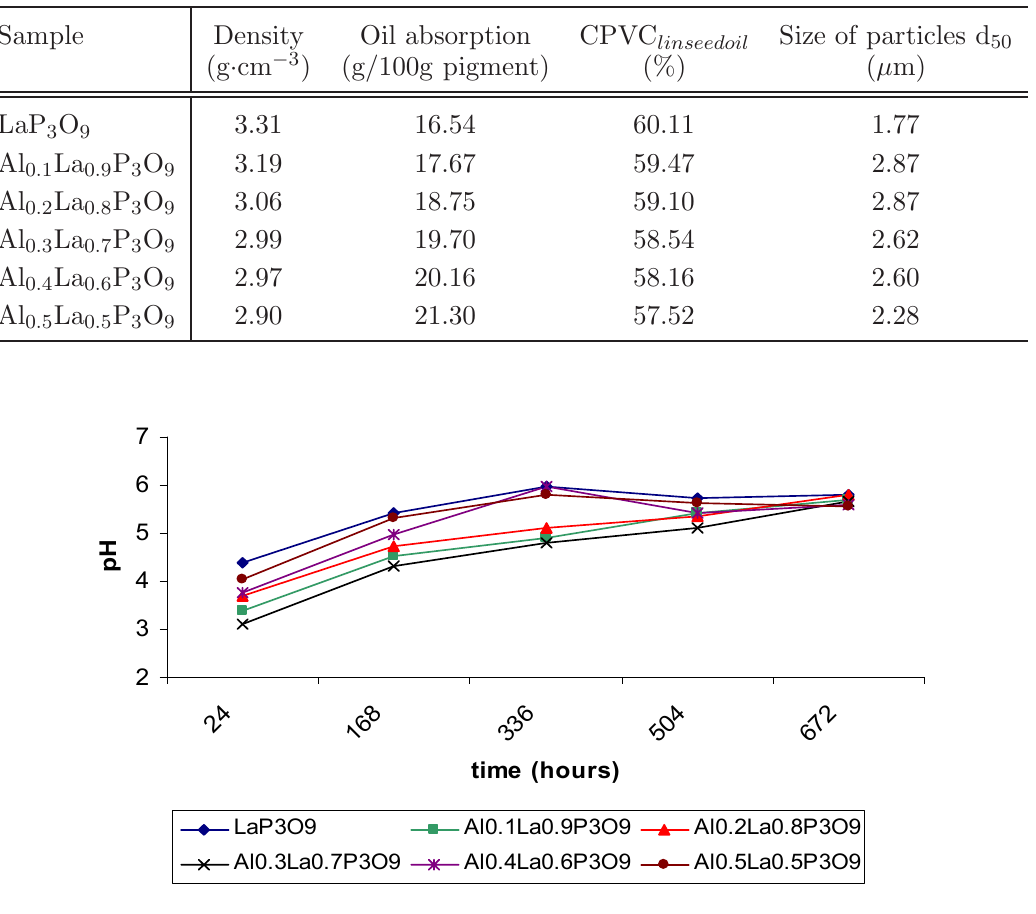
Fig. 7 pH of 10% pigments water suspension with steel plates.